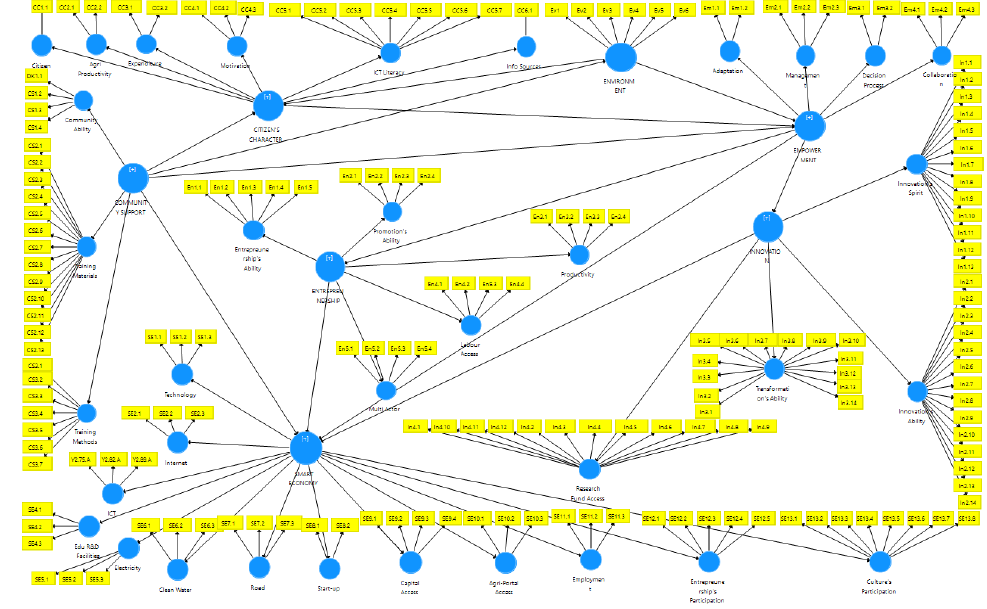
Fig. 4. Model of second-order citizen science for a smart economy